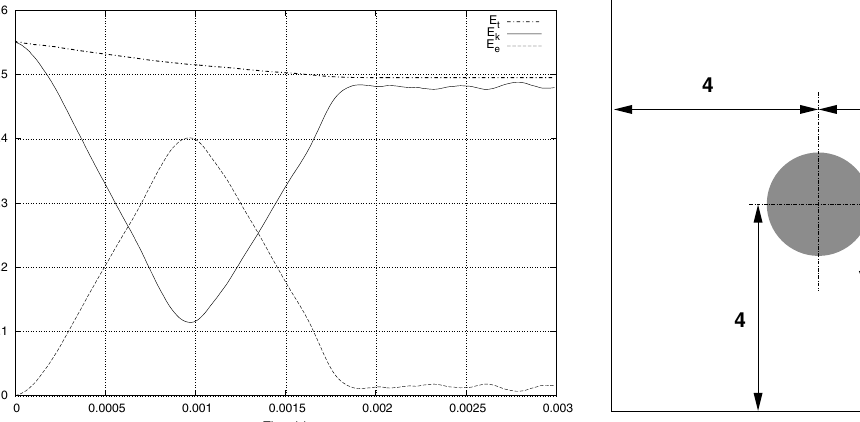
Fig. 5. Impact of two cylinders inside rigid walls.